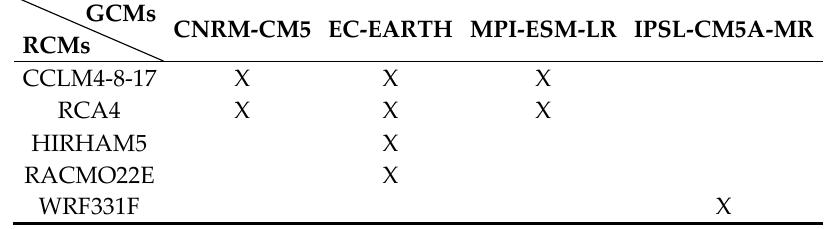
Table 1. Regional Climatic Models (RCMs) and General Circulation Models (GCMs) considered to define the climatic scenarios.